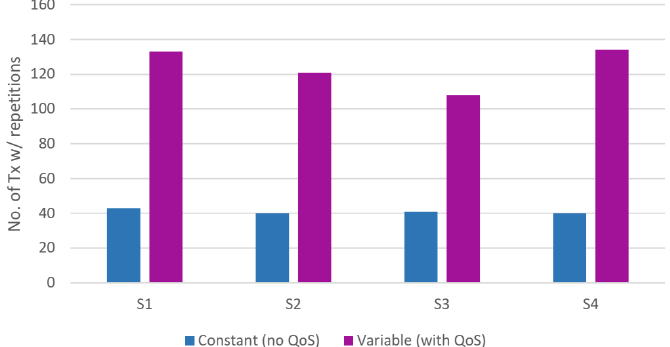
Figure 12. Repeat count feature of QoS.